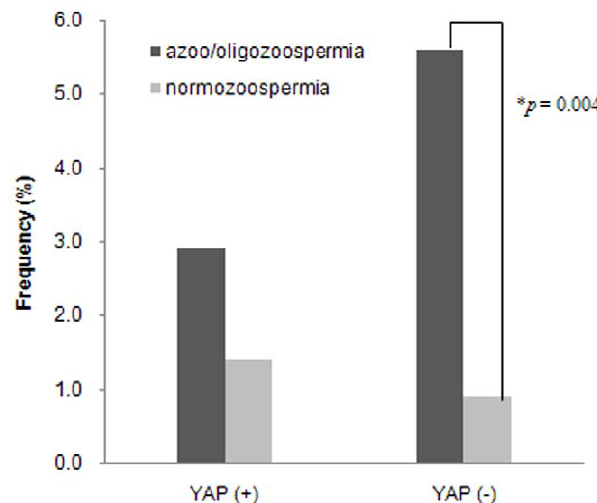
Figure 2. Comparison of gr/gr deletion frequencies between azoo-/oligozoospermic and normozoospermic groups in YAP + and YAP 2 haplogroups. * Fisher’s exact test (two-tailed), OR=6.341 (95% CI=1.472–27.312), significant at P , 0.05.